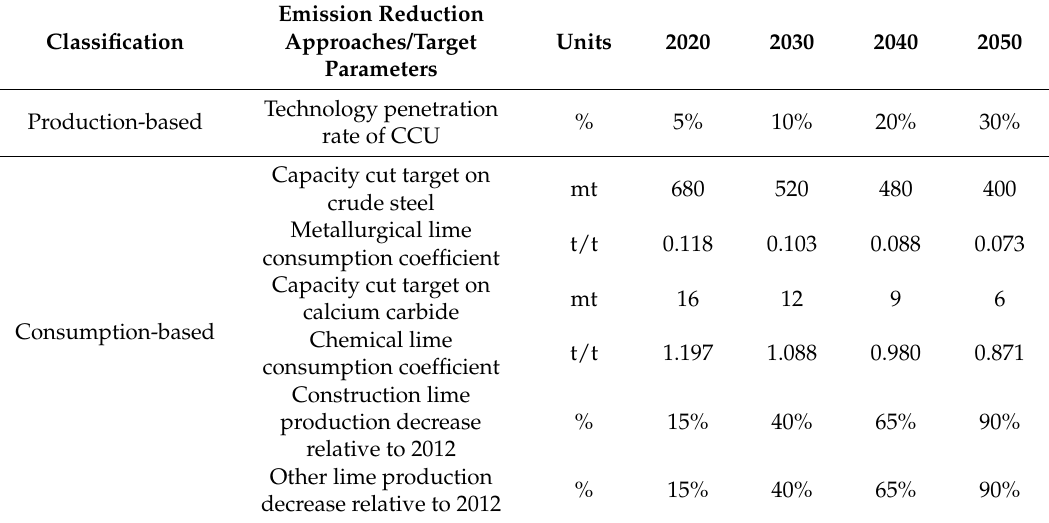
Table 4. Emission reduction approaches and target parameters under the SRS.